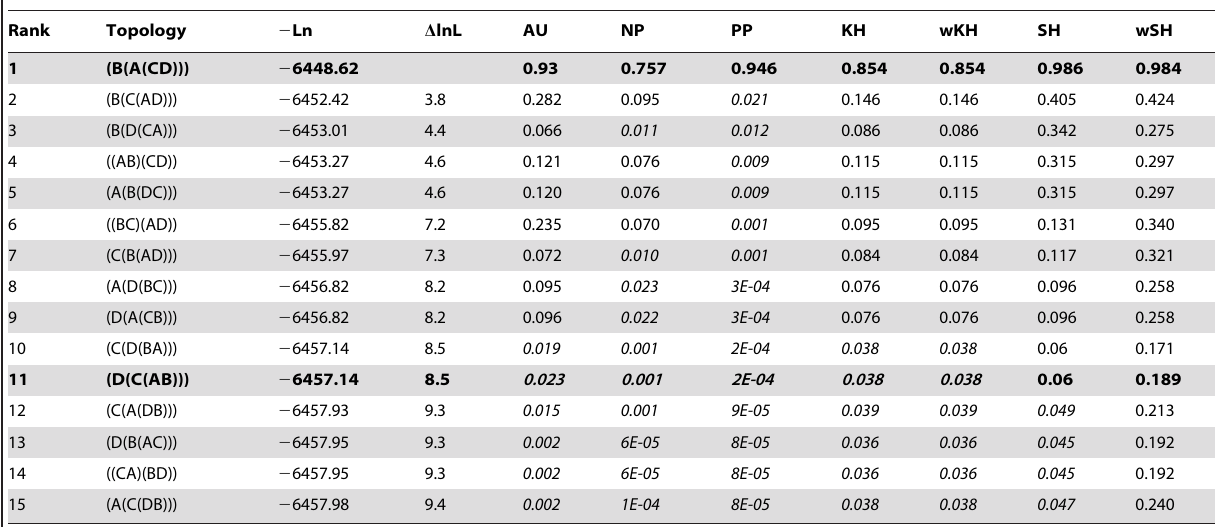
Table 2. Hox cluster duplication topology tests.